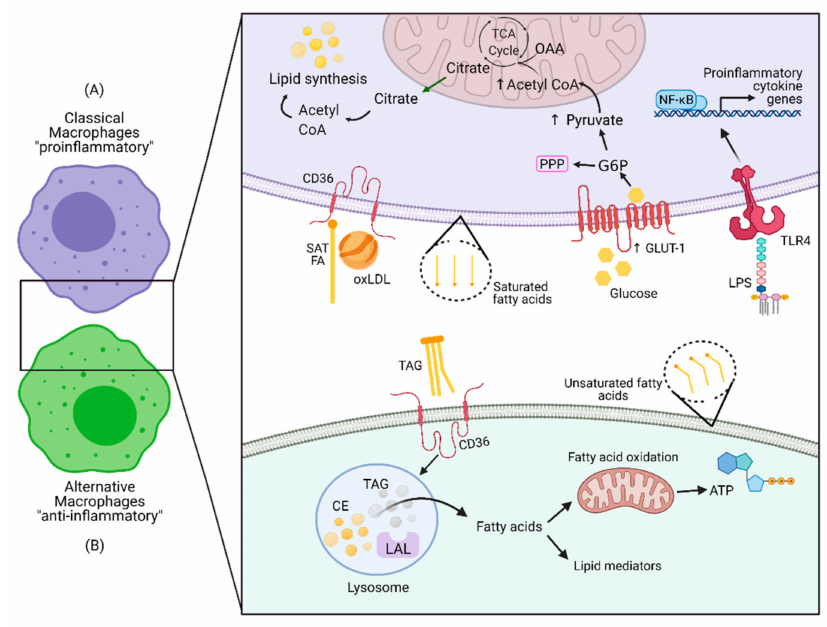
Figure 1. Overview of macrophage metabolism. ( A ) Classically activated macrophages (proinflam- matory macrophages [M1]) present a more glycolytic metabolism, even in the presence of oxygen. Their increased GLUT-1 transporter enables higher glucose influx and enhances pentose phosphate pathway (PPP) activity, which is essential for the inflammatory phenotype. The incomplete TCA cycle generates excess citrate, which is crucial for de novo lipid synthesis. The membrane of M1 macrophages has a high content of saturated fatty acids, especially palmitic acid. LPS binding to TLR- 4 activates nuclear factor kappa B (NF- κ B), responsible for transcription of proinflammatory cytokine genes. ( B ) Metabolism in alternatively activated macrophages (anti-inflammatory macrophages [M2]) mainly produces ATP via the TCA cycle and oxidative phosphorylation (OXPHOS) fueled by fatty acid β -oxidation. There is low glycolysis and PPP activity in this subtype of